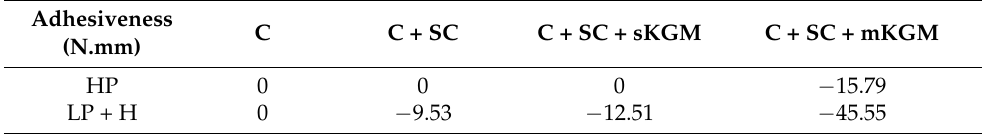
Table 2. Effects of addition of various levels of SC and KGM on the adhesiveness of different gels.